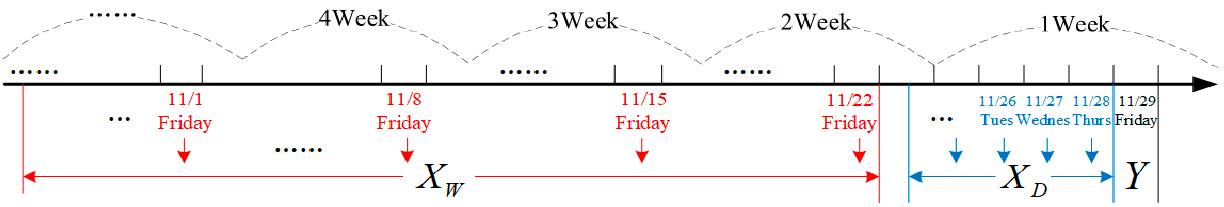
Figure 6. The structure of the DC-STGCN model.